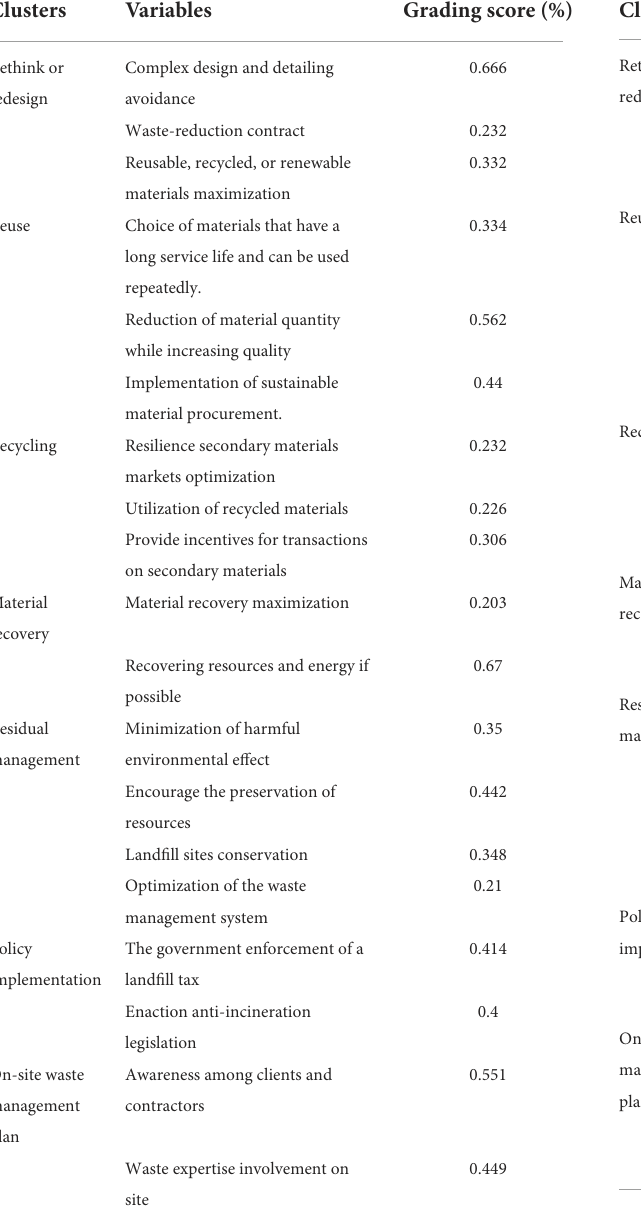
TABLE 2 Scores of